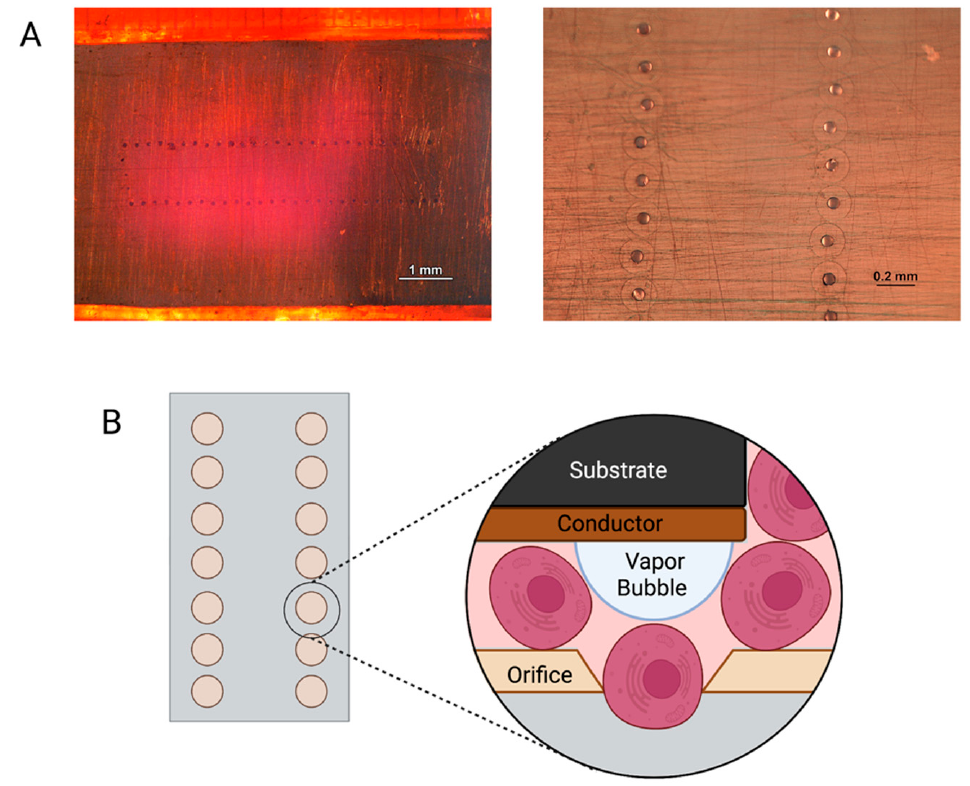
Figure 5. ( A ) Images of inkjet printer cartridge nozzles under a light microscope. ( B ) Schematic representation of cells being printed through an inkjet nozzle.